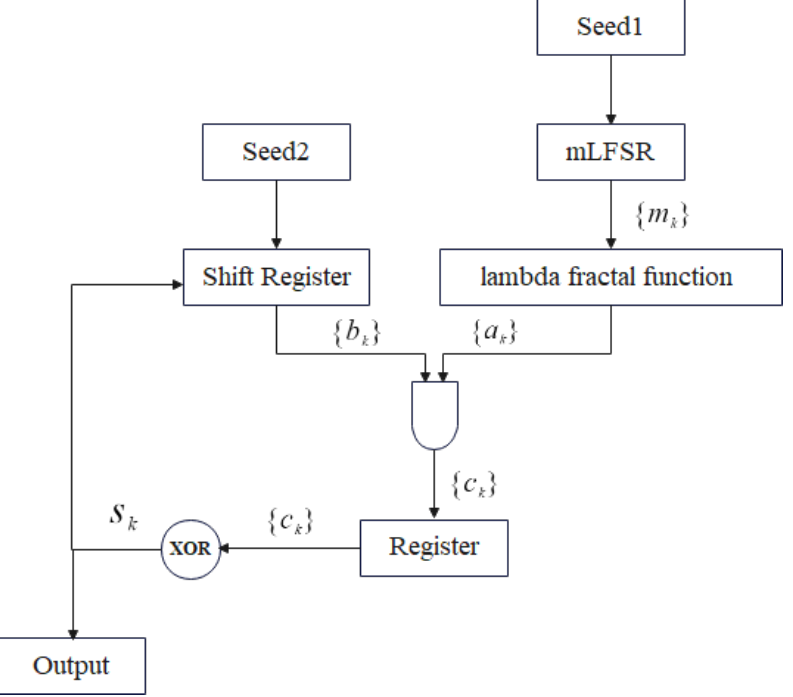
Figure 5. Nonlinear pseudorandom sequence generator, which uses one m-sequence LFSR, two logic gates and two